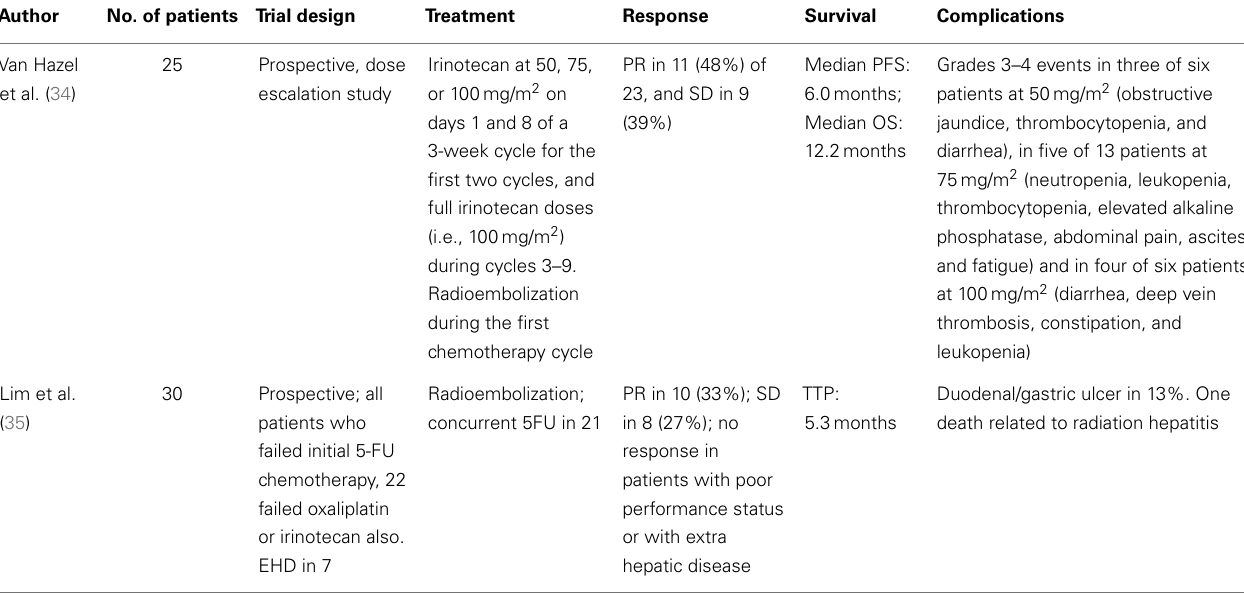
Table 3 |Yttrium-90 radioembolization in combination with second- or third-line chemotherapy